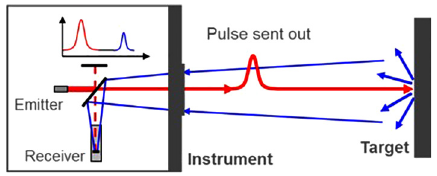
Figure 3. Wave form digitizer technique